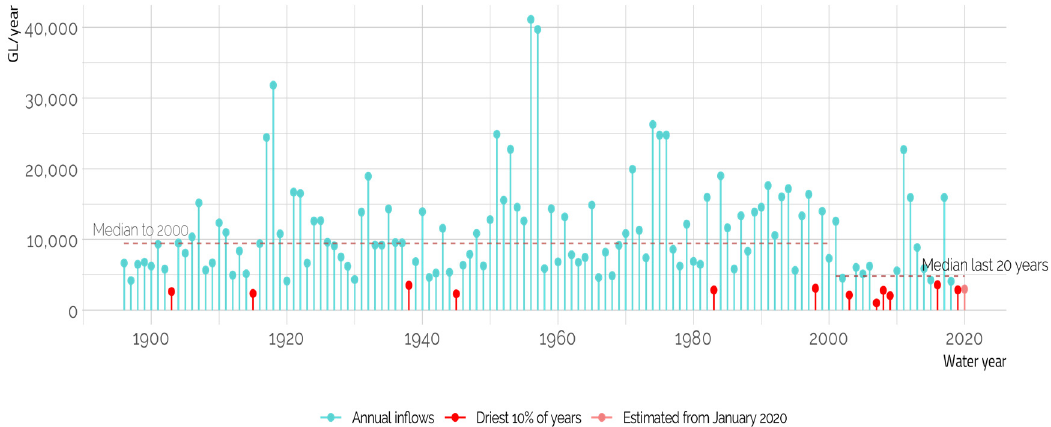
Figure 2. Plot of annual inflows to the rivers of the Murray–Darling Basin (MDB) over 120 years. A drying trend is visible from the late 1990s, with the majority of the driest 10% of years occurring since 1998 (Source: MDBA supplied the data, Rod Marsh provided the plot).